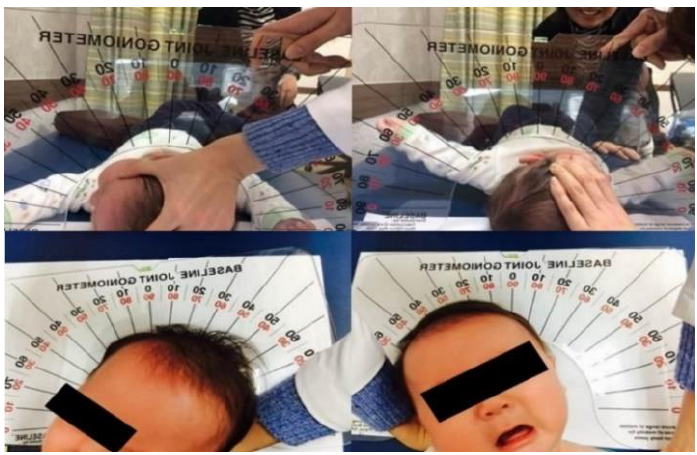
Figure 1. Cervical range-of-motion measurement using arthrodial goniometer (adapted from Hwang et al. Changes in muscle stiffness in infants with congenital muscular torticollis 2019; 9(4); 158 [20]). If there was a difference in the ROM of the SCM between the affected side and the unaffected side in either plane, we marked the case to have the LOM of the neck. Ultrasonography for the bilateral SCM was performed by a radiologist using a com- mercial ultrasound system (Virtual Touch Imaging, ACUSON S2000 Ultrasound Unit, Siemens, Mountain View, CA, USA) initially. During the examination, children were placed in the supine position, with their heads slightly tilted to the opposite side and their necks gently extended by placing a small rolled towel below the shoulder. The thickness of the SCM muscle was measured in the longitudinal and transverse planes (Figure